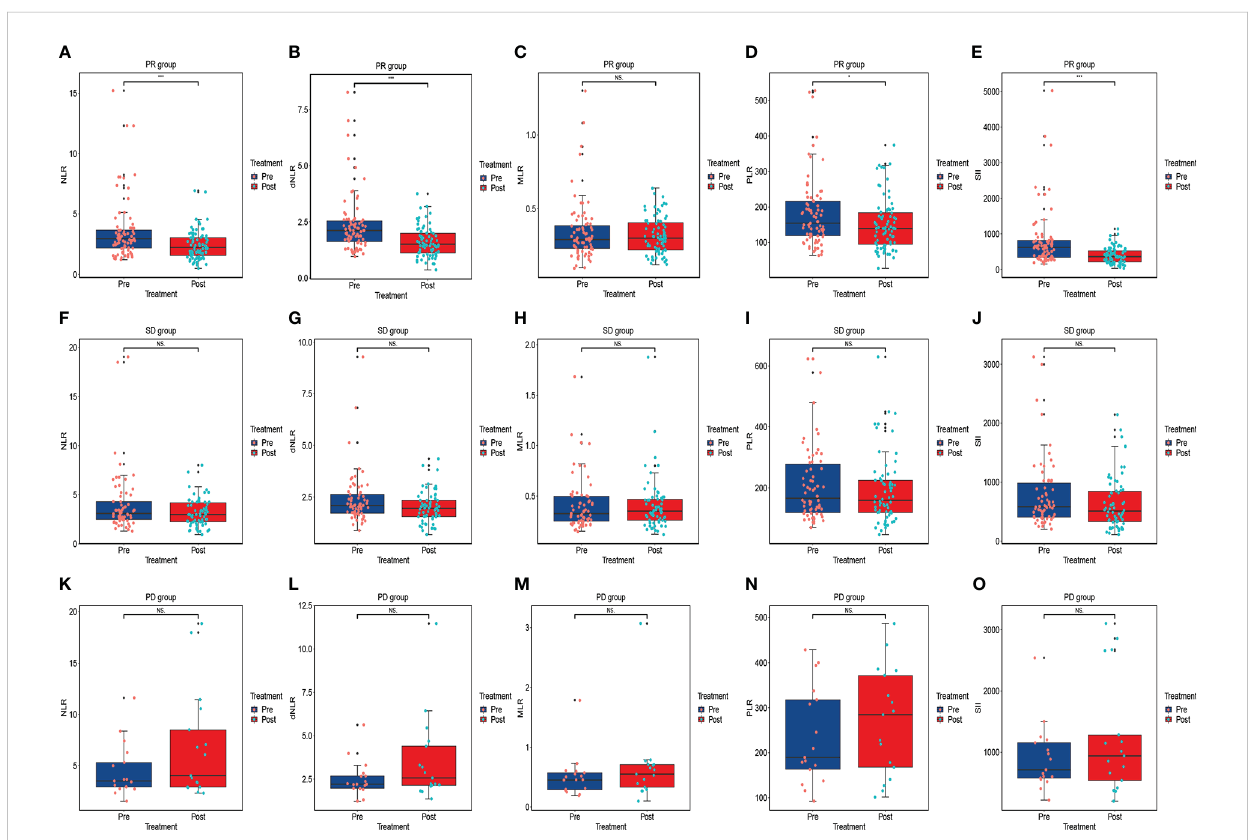
FIGURE 3 The changes in in fl ammatory markers in advanced or metastatic ESCC patients according to the short-term ef fi cacy of anti-PD-1 treatment including PR group (A – E) , SD group (F – J) , and PD group (K – O) . NS, No statistic signi fi cance; *P < 0.05;